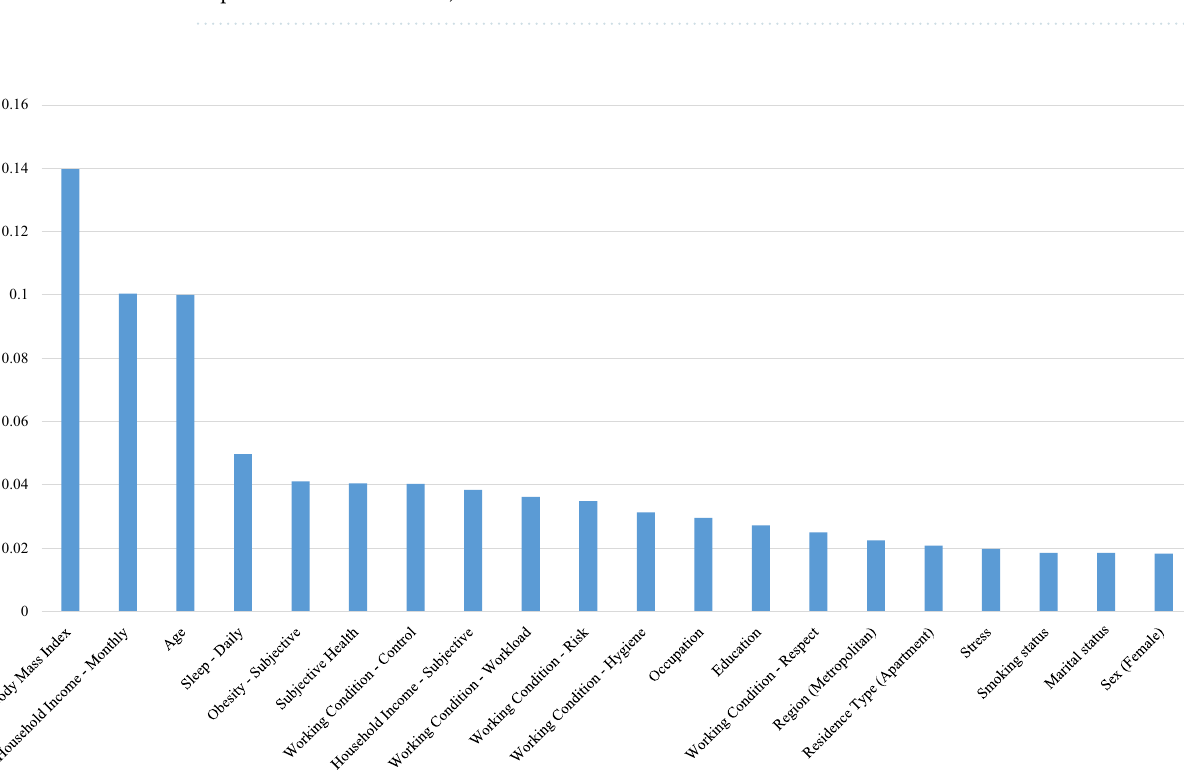
Table 4. Random forest variable importance. *404 observations were randomly sampled without replacement from 4643 observations with TMD Self-Reported “No” (The proportion of observations with TMD Self- Reported “Yes” became 20%).